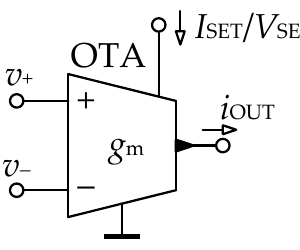
Figure 1. OTA schematic symbol.